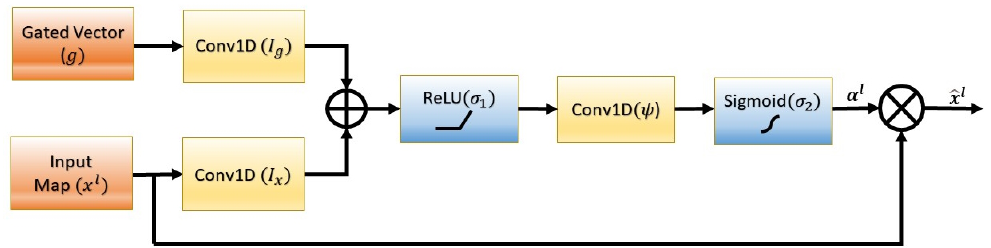
Figure 1. A series of transformations to process the input features and the gating vector to generate the attention coefficients. The input features are scaled by attention coefficients so that the relevant part of the inputs is highlighted and the irrelevant part is